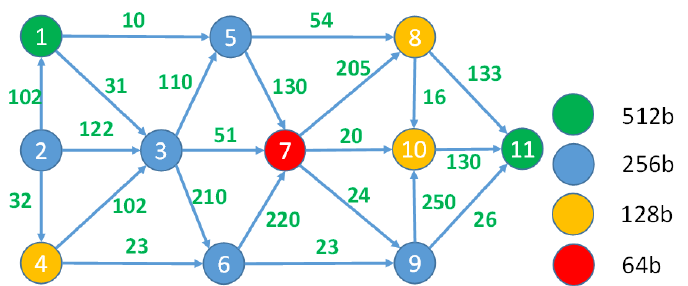
Figure 8. Latency (shown as the weights of the corresponding edges) and security (expressed in security bits and indicated by nodes of different colors) of the infrastructure represented as the graph.